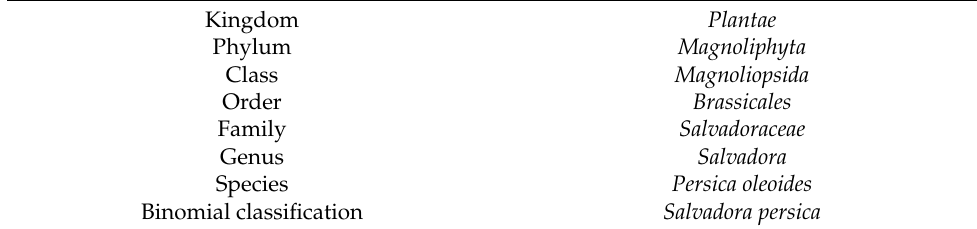
Table 1. Systematic classification of Salvadora persica